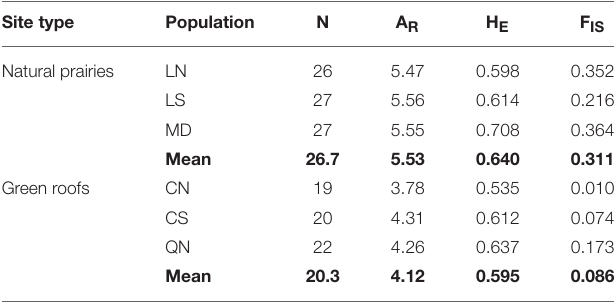
TABLE 2 | Genetic summary statistics for three natural prairie and three green roof populations: Number of individuals (N), allelic richness (A R ), expected heterozygosity (H E ), and mean inbreeding coefficient (F IS